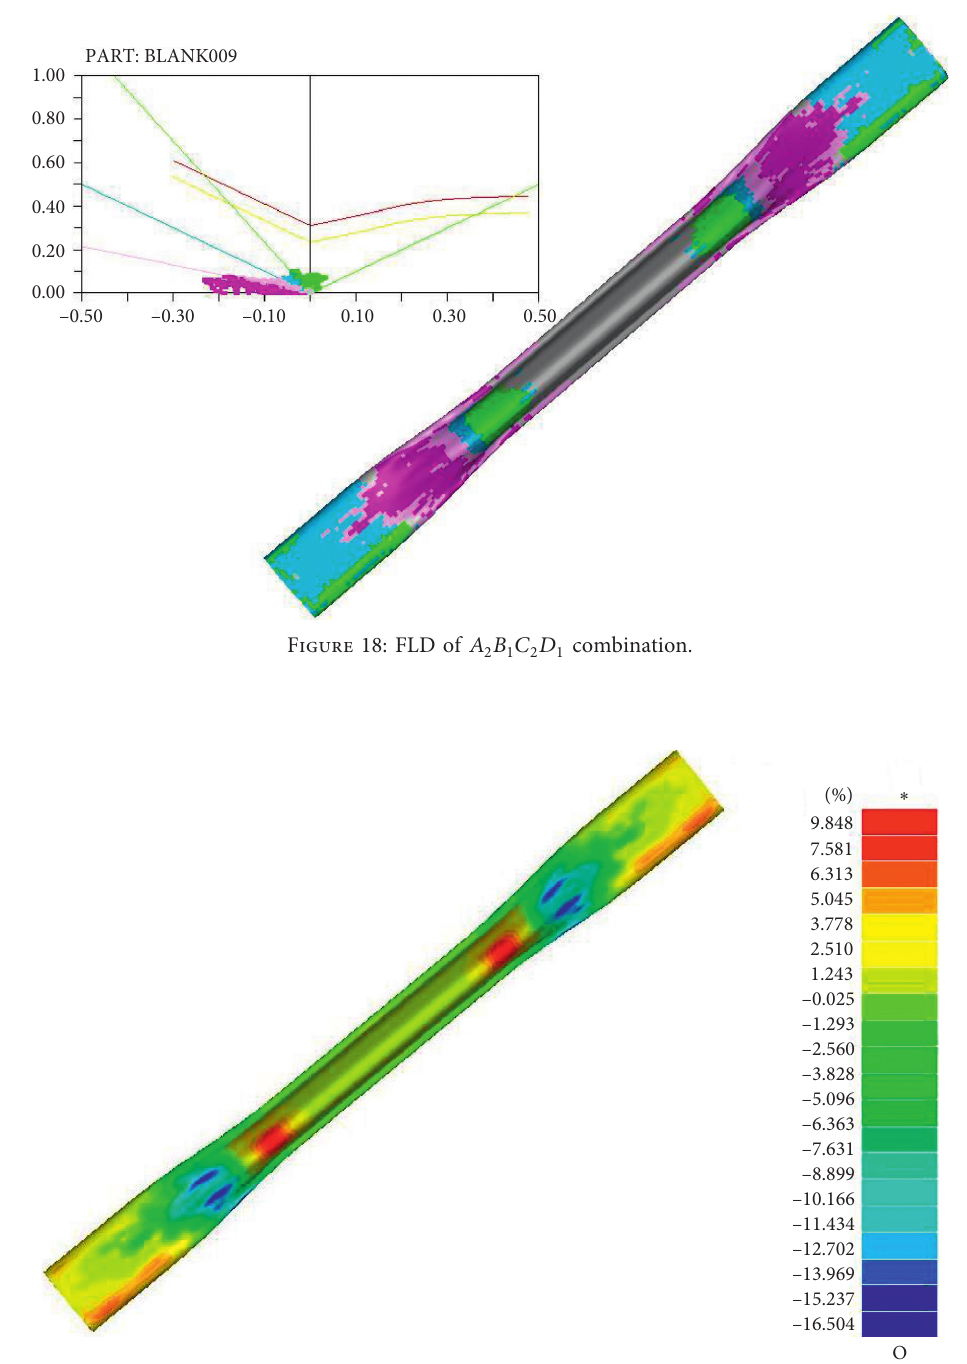
B C D combination. 2 1 2 1